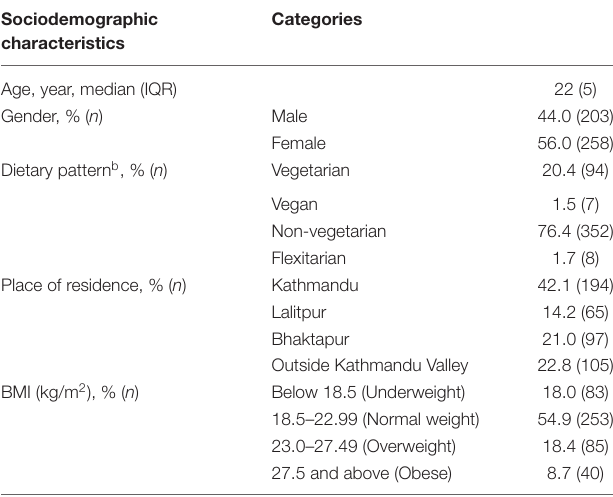
TABLE 1 | Sociodemographic characteristics of the participants, N = 461 a